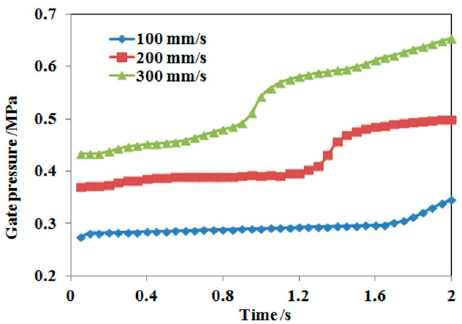
Figure 4. Gate pressure as a function of time at three injection speeds.